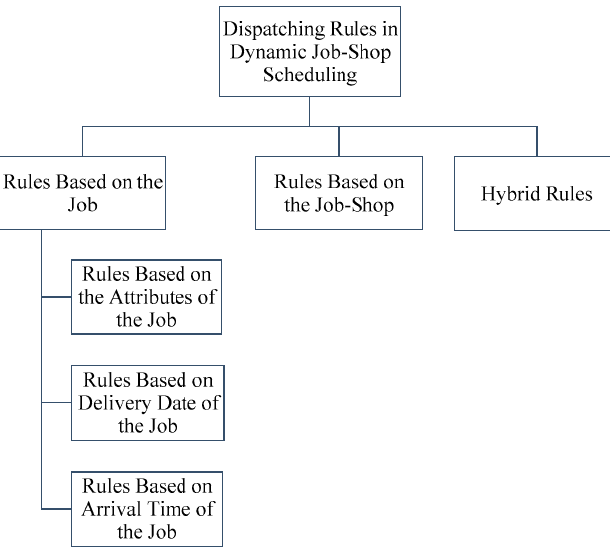
Figure 2. Dispatching rules in job-shop scheduling.